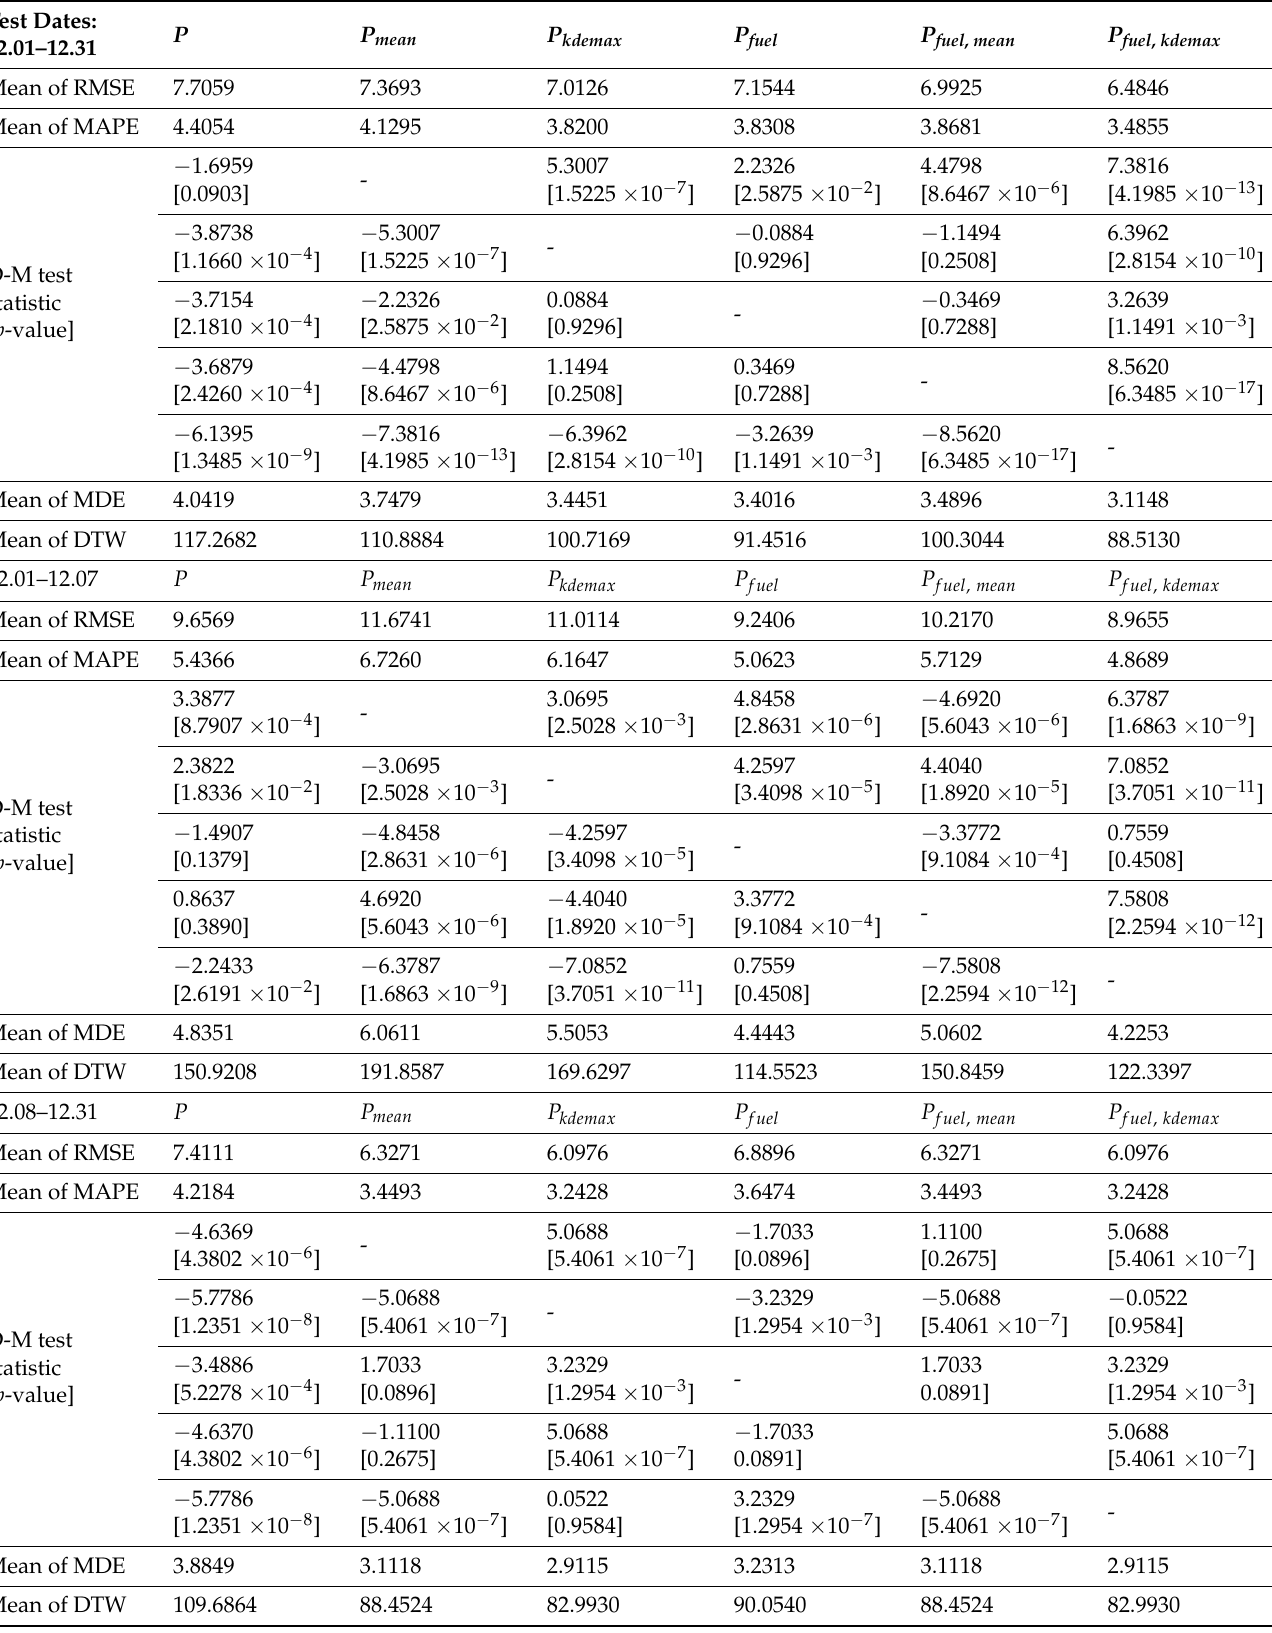
Table 5. The comparison of P forecasting of the 2 nd case study using the same feature with P fuel , divided by the test